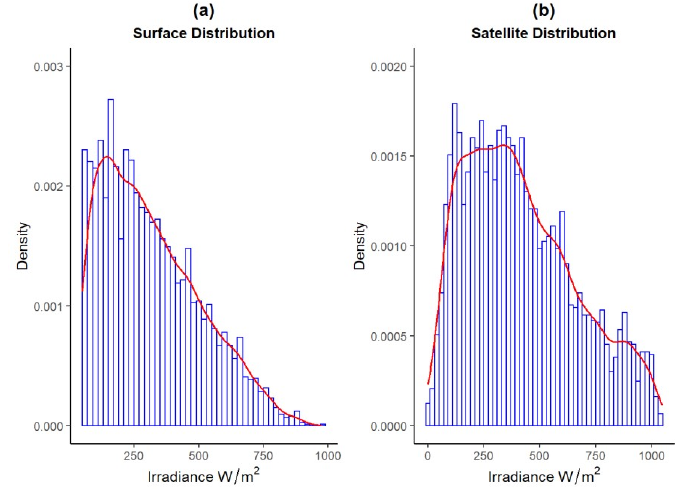
Figure 11. Histogram of frequency for hourly GHI profile. ( a ) Shows the irradiance distribution for the surface measurements. ( b ) Shows how the irradiance of the satellite estimates is distributed.